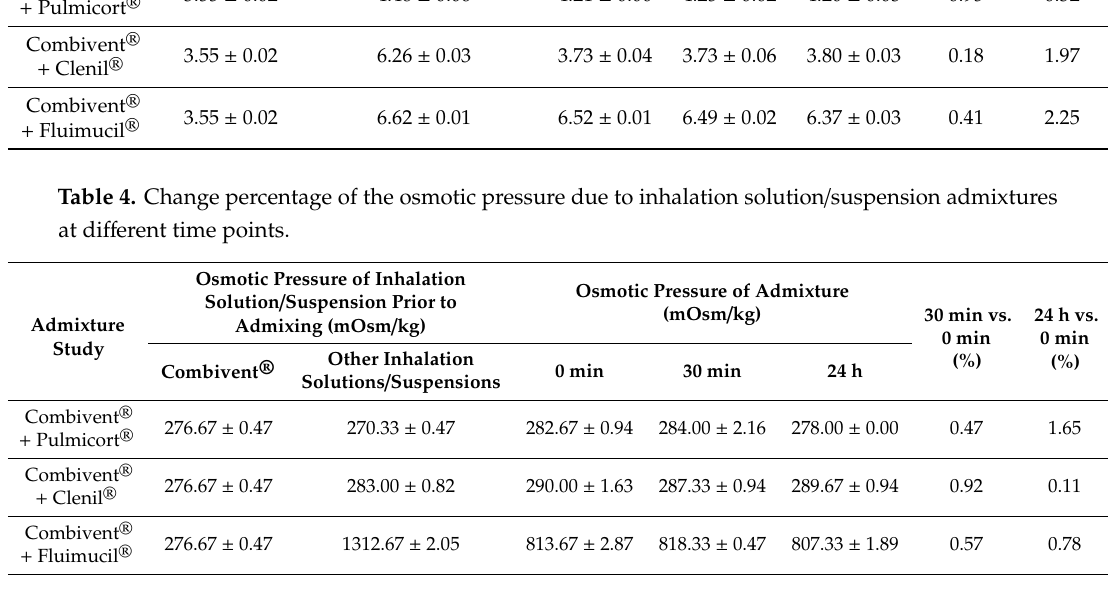
Table 5. Change percentage of the content due to inhalation solution / suspension admixtures at di ff erent time